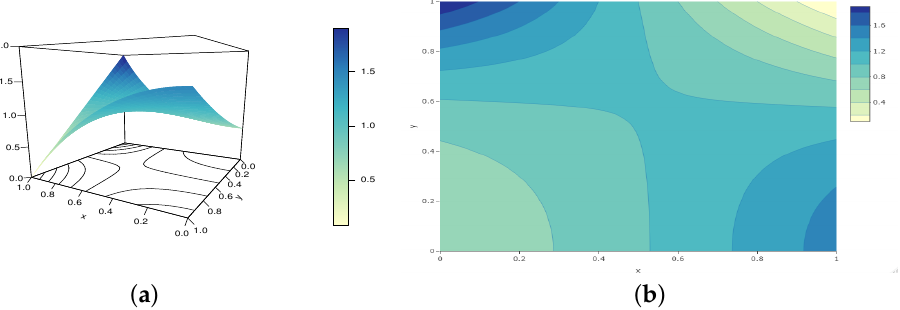
Figure 5. Illustrations of the ( a ) perspective plot and ( b ) contour plot of the GCC copula density for the following configuration: a = − 1/2, b = 2, and c = 1, belonging to Configuration 2.